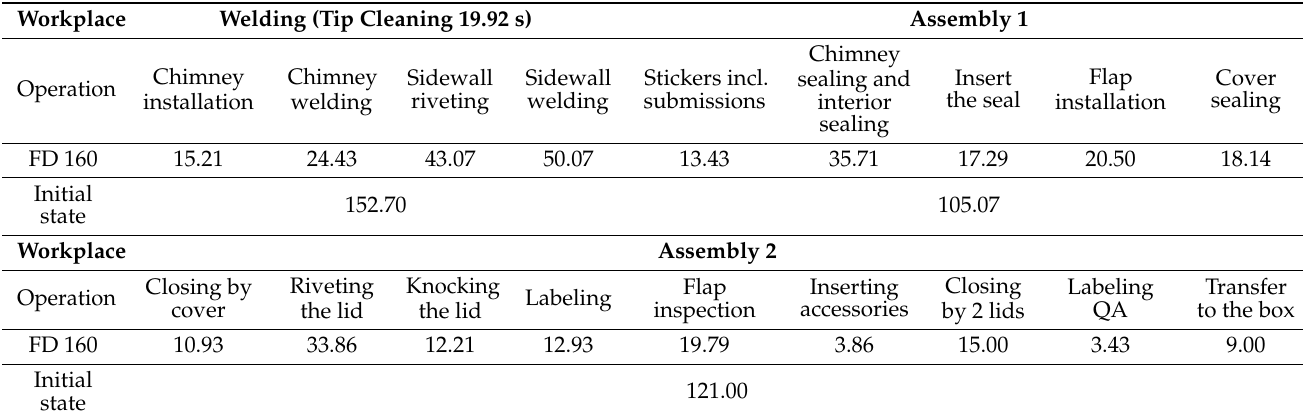
Table 4. Average assembly time (in seconds) according to workplaces and assembly line operations.